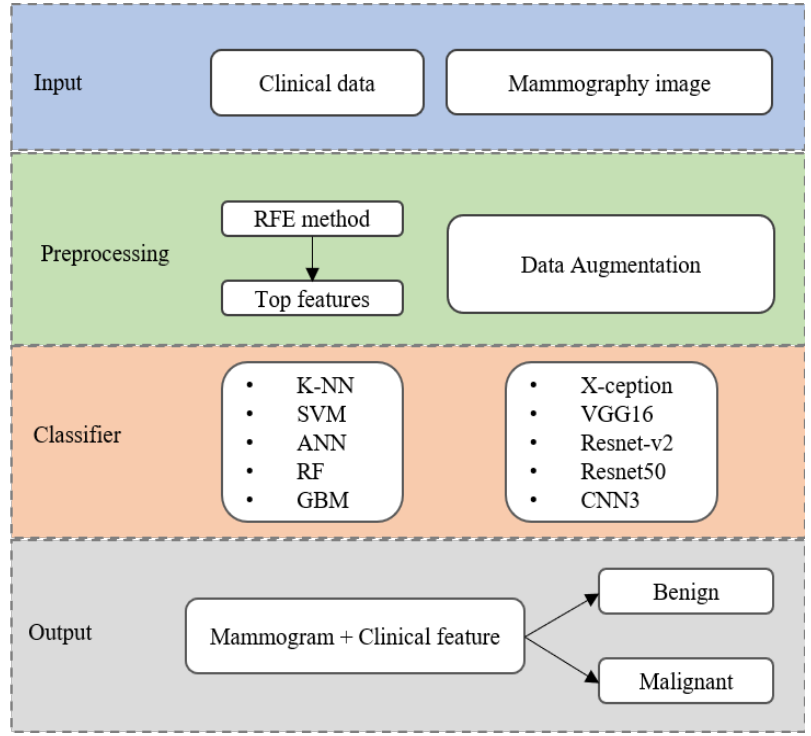
Figure 1. The flowchart of the proposed algorithm using ML-DL model for breast cancer detection.